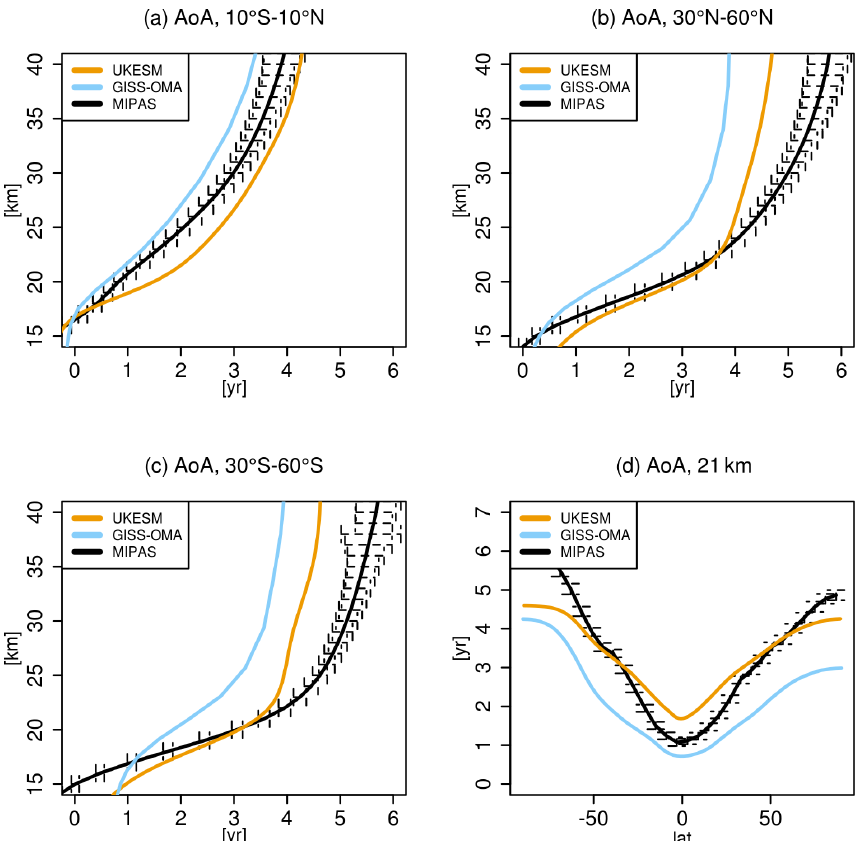
Figure 3. Normalized age of air (AoA; years) at (a) 10 ◦ S–10 ◦ N, (b) 30 ◦ S–60 ◦ N, (c) 30 ◦ N–60 ◦ S, and (d) 21km diagnosed from the UKESM (orange) and GISS-OMA (light blue) CMIP6 historical integration. Note that the GISS-OMA simulation uses prescribed sea surface temperatures (SSTs) and sea ice (unlike the SAI GISS-OMA simulations, which include an interactive ocean module). Black lines show the corresponding AoA derived from the MIPAS SF6 satellite observations (black; Stiller et al., 2020). Both model and observed AoA values were averaged over the 7-year period from May 2005 to April 2012 inclusive. Both model and observed AoA values were normalized to be zero at the tropical tropopause by subtracting the values calculated in each case for the tropical tropopause layer (here approximated as a mean over 25 ◦ S–25 ◦ N, 16–17km). CESM is not included as no AoA diagnostic is available from its historical CMIP6